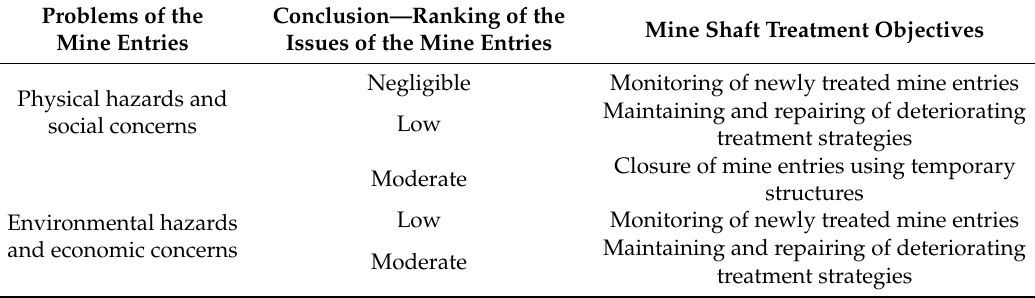
Table 5. Ranking of problems of mine entries and the objectives of their treatment in the Giyani and Musina areas.